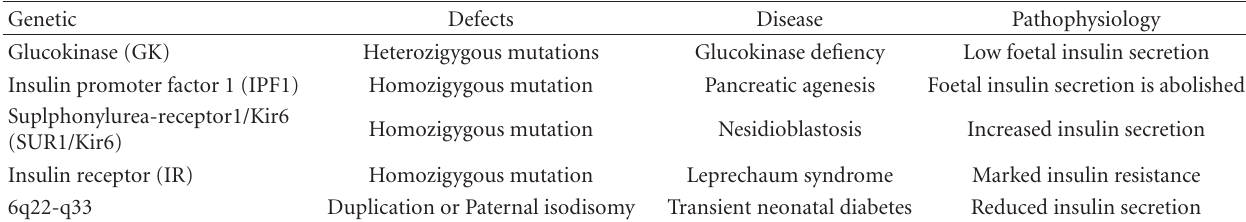
Table 2: Monogenic defects associated with insulin-resistant dependent